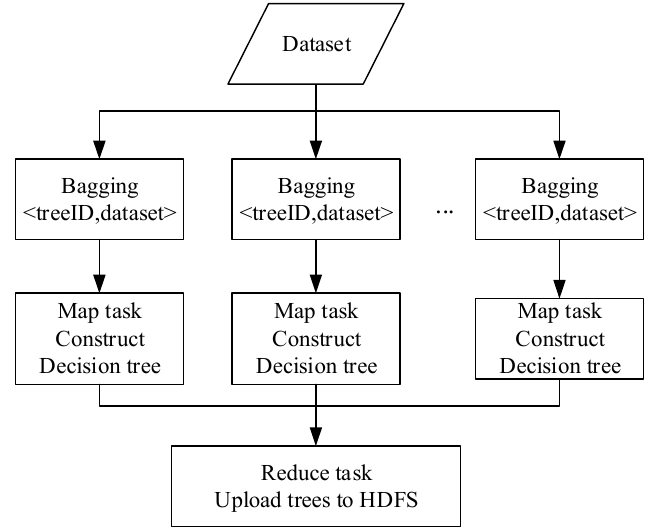
Figure 5. The parallel forest construction process of random forest.